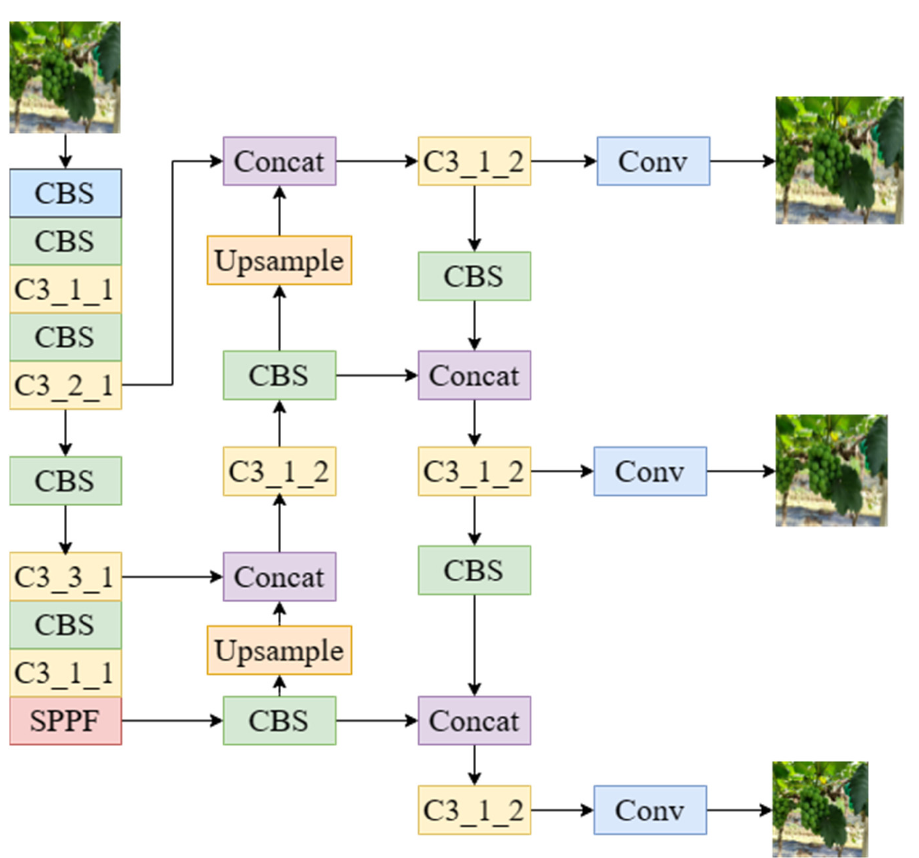
Figure 2. YOLOv5s-6.0 algorithm structure diagram.